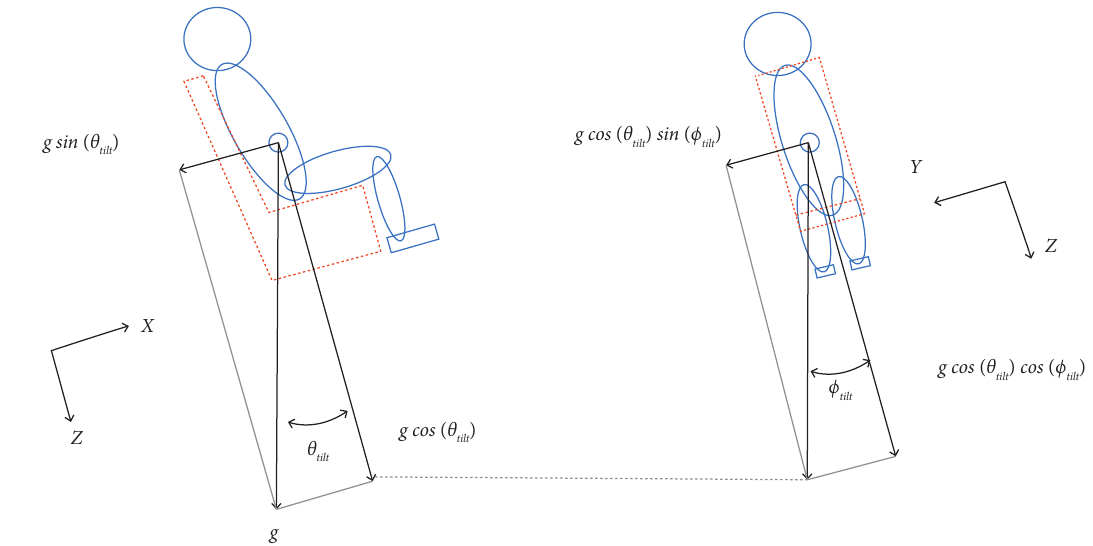
Figure 5. Illustration of the tilt angles and specific forces in the simulator (Vargas